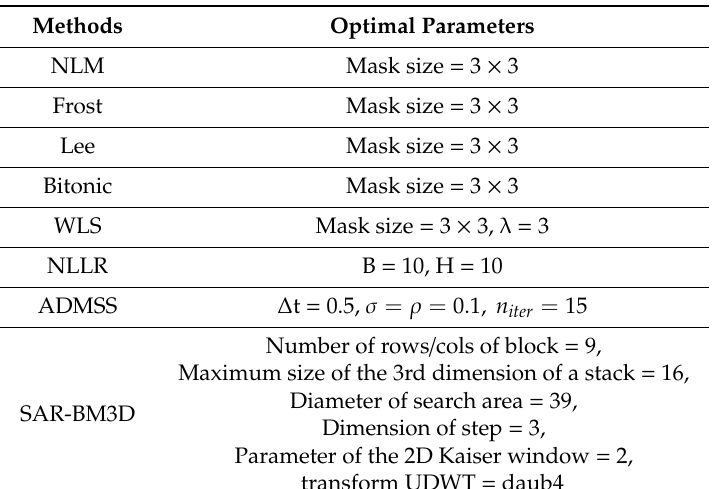
Figure 9. Test images. ( a ) Baboon (512 × 512); ( b ) Lena (512 × 512); ( c ) Cameraman (256 × 256); ( d ) Airplane (512 × 512); ( e ) Hill (512 × 512); ( f ) Man (512 × 512); ( g ) Barbara (512 × 512); ( h ) Peppers (256 × 256); ( i ) Boat (512 × 512); ( j ) House (256 × 256); ( k ) Monarch (748 × 512); ( l ) Napoli (512 × 512); ( m ) Fruits (512 × 512); ( n ) Zelda (512 × 512). Table 3. The optimal parameters of existing filters in standard images.